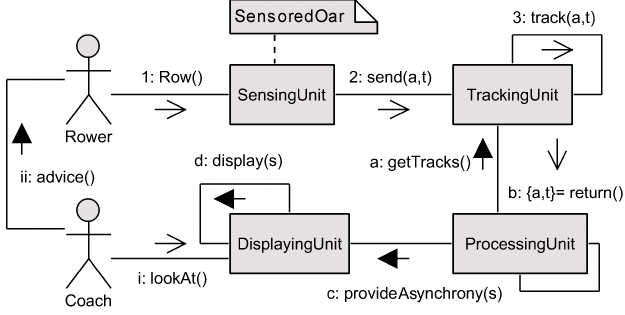
Figure 3. Communication diagram of the main modules of the multi-agent system for assessing rowers’ coordination via motion-based stigmergy (MARS)